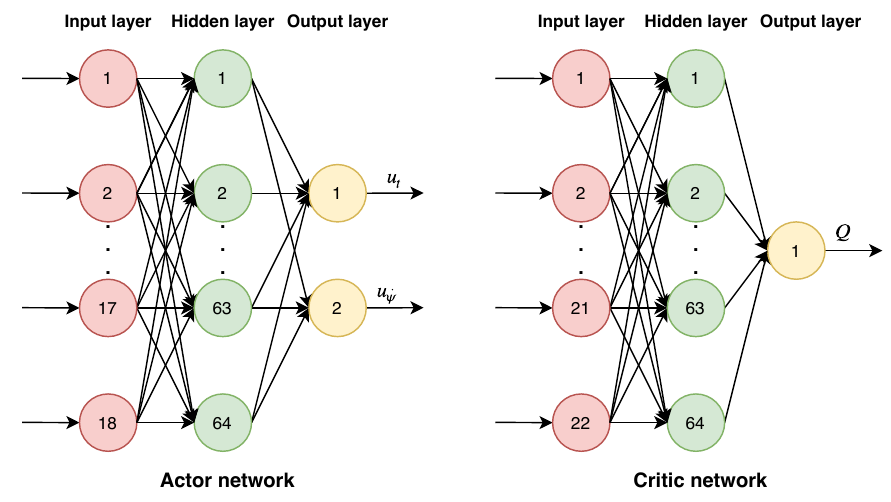
Figure 5. Actor and critic network structure.